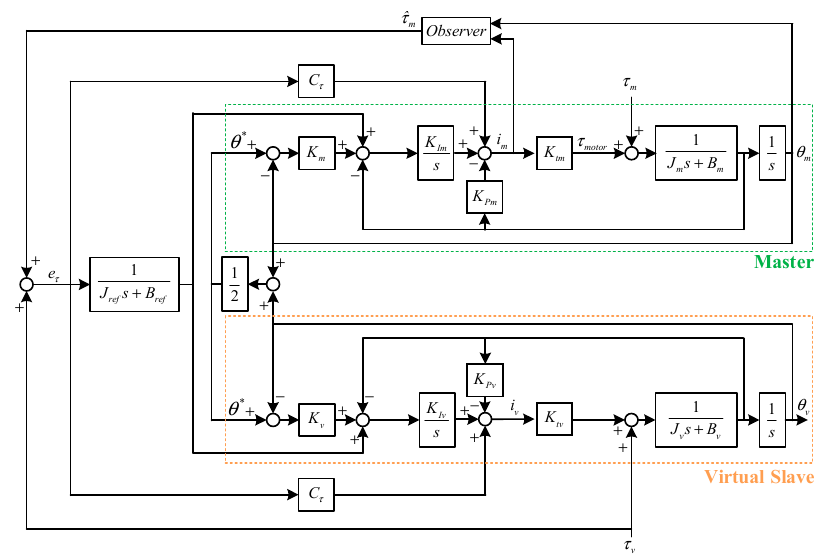
Figure 2. Torque observer-based bilateral control